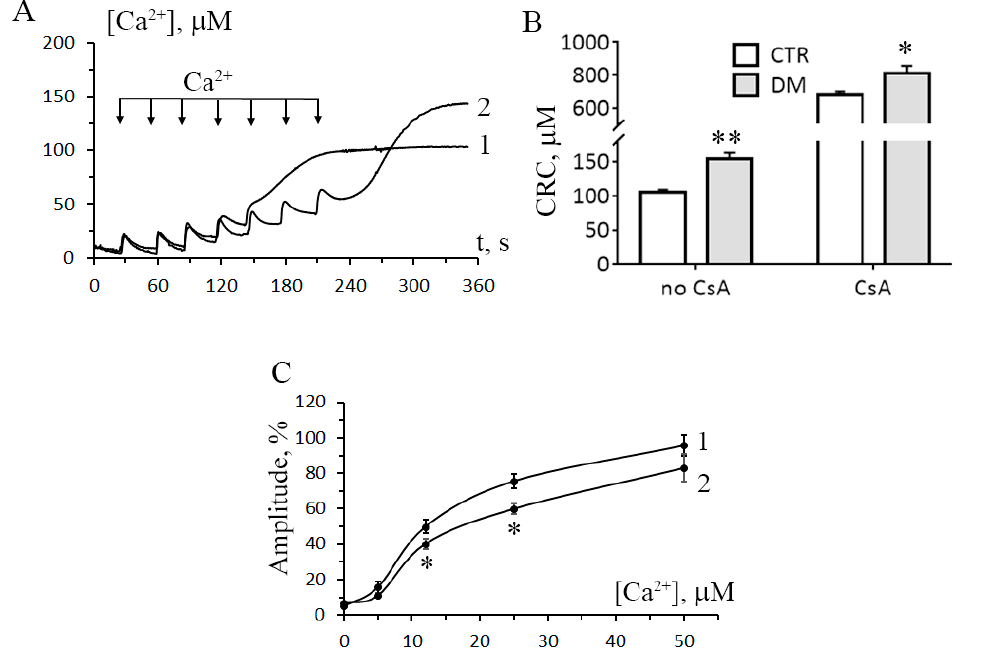
Figure 3. Diabetes increases the resistance of rat liver mitochondria to the opening of mitochondrial permeability transition (MPT) pore. ( A ) Changes in the external [Ca 2 + ] upon successive addition of small Ca 2 + doses (25 µ M) to the suspension of liver mitochondria of control (trace 1) and STZ-treated (trace 2) rats. ( B ) Ca 2 + capacity of liver mitochondrial of control and diabetic animals in the absence and presence 1 µ M CsA. The values are given as means ± SEM ( n = 5). The medium composition was as indicated in Figure 1A. ( C ) The amplitude of Ca 2 + -induced swelling of liver mitochondria of control (curve 1) and diabetic (curve 2) rats versus Ca 2 + concentration. The incubation medium contained 210 mM mannitol, 70 mM sucrose, 5 mM succinate, 10 µ M EGTA, 1 µ M rotenone, and 10 mM Hepes / KOH bu ff er, pH 7.4. The concentration of mitochondrial protein was 0.4 mg / mL. The values are given as means ± SEM ( n = 4). * p < 0.05 compared to controls; ** p < 0.01 compared to